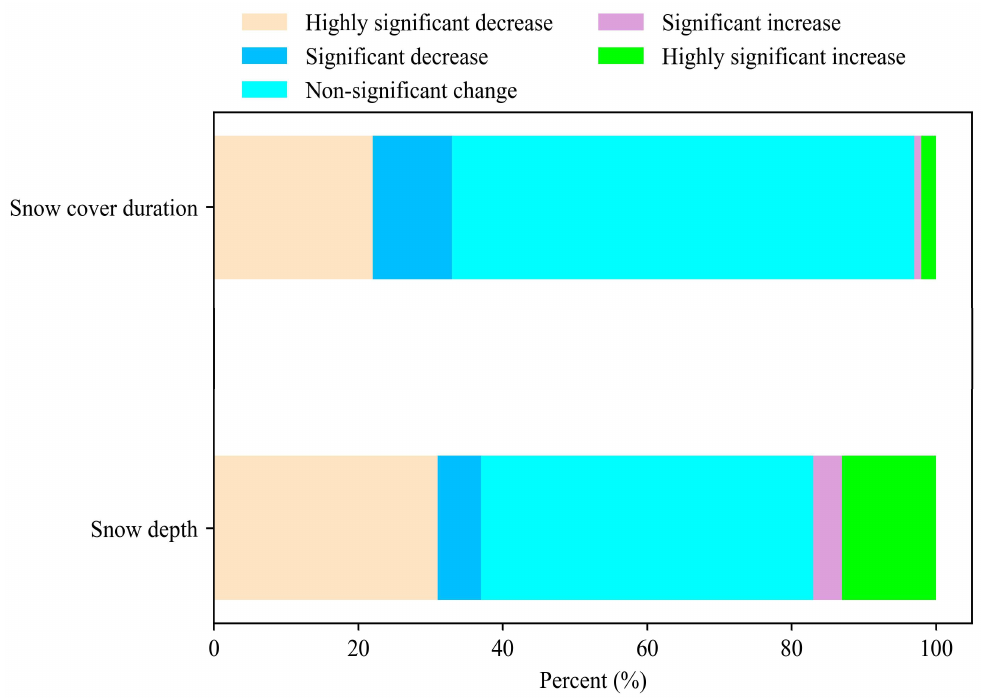
Figure A3. The statistical analysis of the variation trend grades for snow cover days and annual average snow depth during 1992–2016.